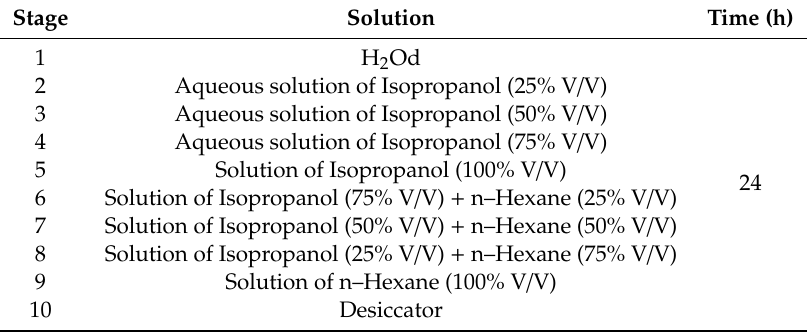
Table A2. Membrane drying process: stages, solvents, and immersion